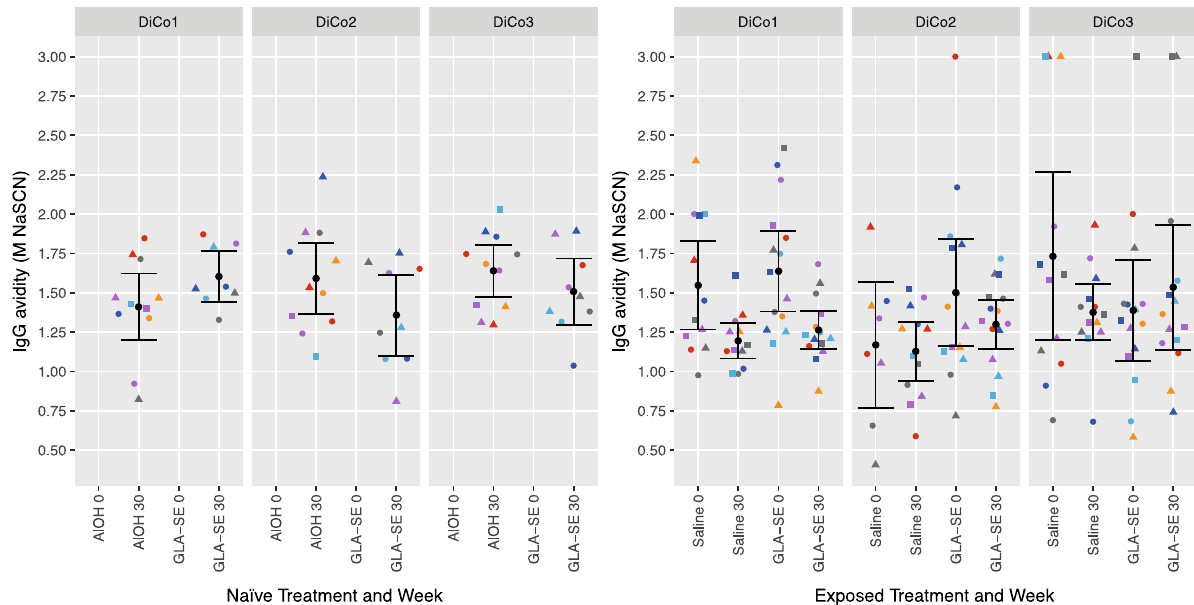
Fig. 3 IgG Avidity Indices (AI) before vaccination and four weeks after the third vaccination to the AMA1 DiCo variants in malaria-naive and malaria-exposed adults. Individual IgG AI levels before vaccination and four weeks after the third are shown. Colours and shapes within treatment groups indicate individual subjects. Summary statistics (arithmetic means with 95% con fi dence intervals) are shown in every